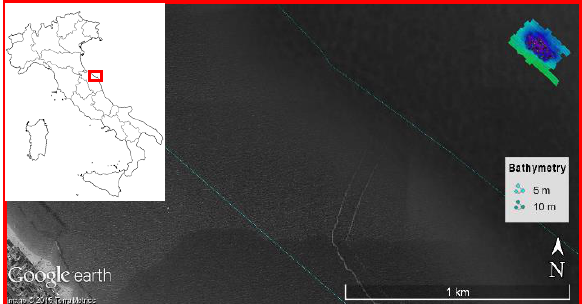
Figure 1. Study area location (Senigallia, Marche region, Italy)